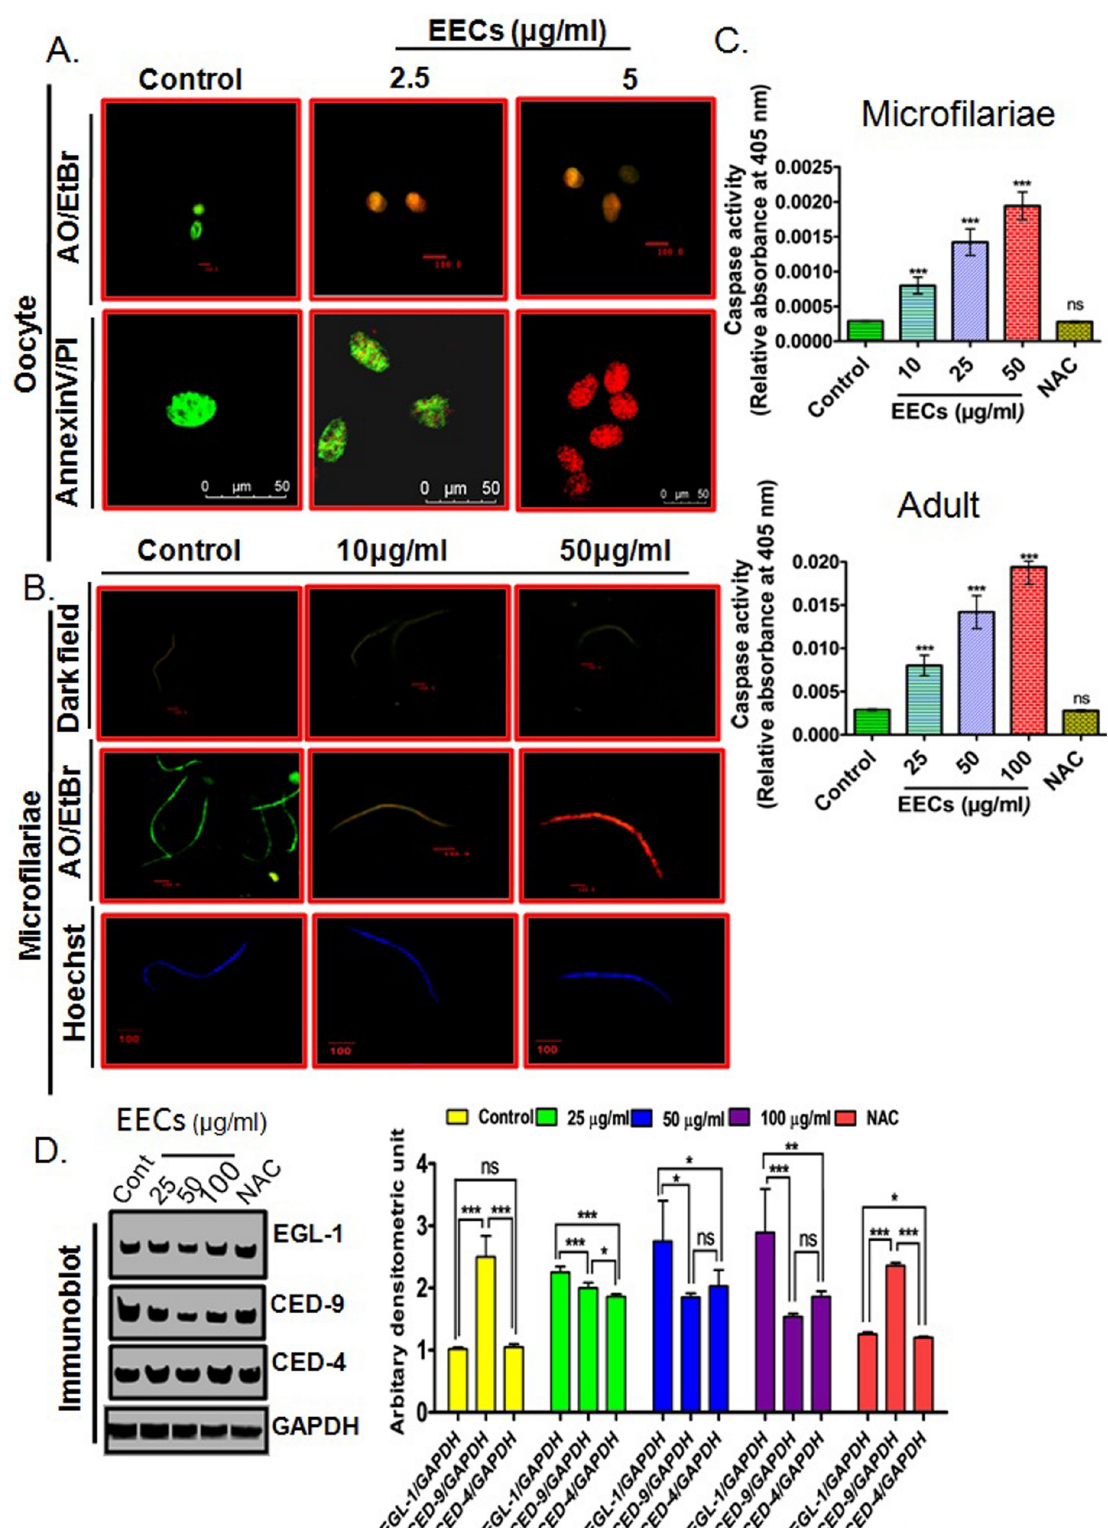
Fig 3. EECs activates apoptotic pathways in S . cervi . (A.) Annexin V-FITC/PI staining showing outward projection of phosphatidylserine indicating induction of apoptosis in oocytes. (B.) Dark field micrograph (upper panel), AO/EtBr double staining (middle panel) and Hoechst staining (lower panel) depicting the induction of apoptosis in Mf. EECs is efficient in inducing apoptosis in